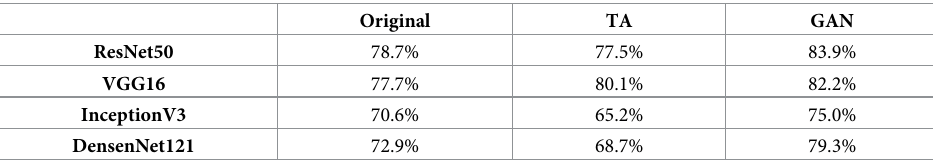
Table 6. Multiclass classification accuracy performance of each CNN